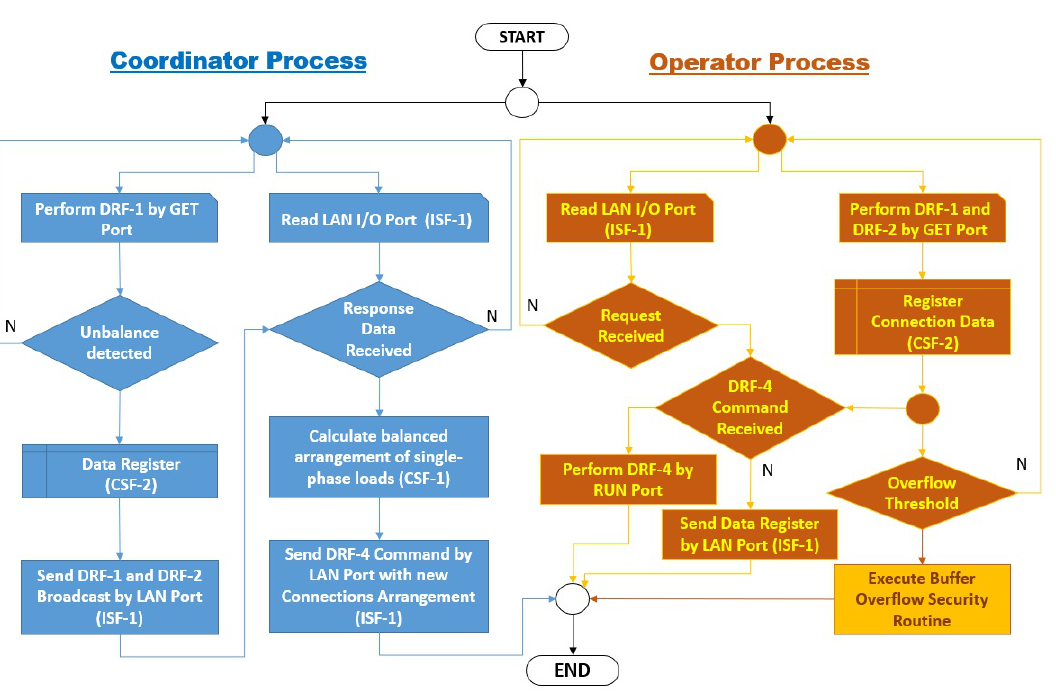
Figure 19. Flow diagram describing the test algorithm for the Phase Unbalance Correction